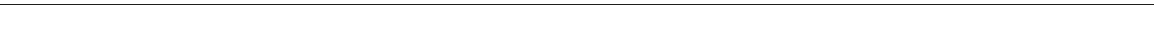
Fig. 5 Synergistic interactions highlight the functionally most relevant HNRNPH binding sites. a Minigene variants are differentially spliced upon HNRNPH knockdown (KD). Scatterplot compares AE inclusion under control (ctrl) and HNRNPH KD conditions for all minigene variants. Average behaviour illustrated by running mean and standard deviation (red). Shadings schematically highlight stronger/weaker-than-average KD response. Minigenes with mutations C307G, G310A and G305A in HNRNPH splice-regulatory binding sites (SRBS) cluster 3 are highlighted. b Quanti fi cation of synergistic interactions by linear regression modelling. Single mutation effects are determined separately for ctrl and HNRNPH KD using linear regression and subtracted to estimate KD responses compared to wt ( z -score based on standard deviation of wt minigenes, colour-coded; see Supplementary Note 3). Right graph shows model-inferred AE skipping-to-inclusion isoform ratios of single mutations in ctrl vs. KD. Regression line indicates average KD effect. Consideration of isoform ratios, as compared to isoform frequencies ( a ), leads to linearisation of KD response in line with predictions of kinetic splicing model (Supplementary Fig. 3a). c Model-inferred synergistic interactions accumulate in RON exon 11. Bar diagrams quantify signi fi cant synergistic interactions affecting AE skipping-to-inclusion isoform ratio using different z -score cutoffs in adjacent 5-nt windows. Line indicates density in 5-nt sliding window. Splice sites ± 2 nt were excluded. Predicted HNRNPH SRBS (brown) are given above. d Mutations in HNRNPH SRBS cluster 3 lead to increased AE inclusion and reduced HNRNPH KD response. Dot plots (top) display single mutation effects (inserted nucleobase, see legend) on AE inclusion (mean, n = 3). Red lines indicate median isoform frequency of wt minigenes ± 2 standard deviations (SD). HNRNPH SRBS (brown) are given above. Heat maps (bottom) show z -scores as measure of synergy (mean, n = 3) per inserted nucleobase. White or grey fi elds indicate mutations that were not present or fi ltered out, respectively (see Methods). Purple boxes highlight signi fi cant synergistic interactions (0.1% FDR). e Consistent with strong synergistic interactions (colour-coded), mutations in cluster 3 almost completely abolish the HNRNPH KD response in MCF7 cells. Scatterplot compares model- inferred estimates with semiquantitative RT-PCR measurements of AE inclusion (circles) and AE skipping (triangles) upon HNRNPH KD (mean, n = 3) for ten targeted mutations in HNRNPH SRBS (Supplementary Data